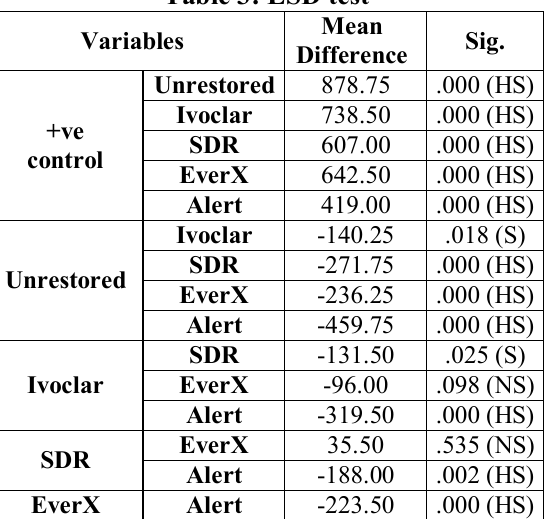
Table 3: LSD test